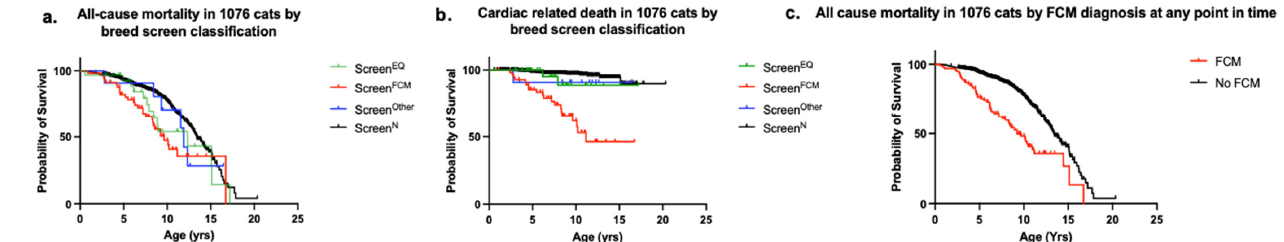
Figure 5. ( a ) All-cause mortality Kaplan–Meier survival curves in 1076 cats by breed-screen